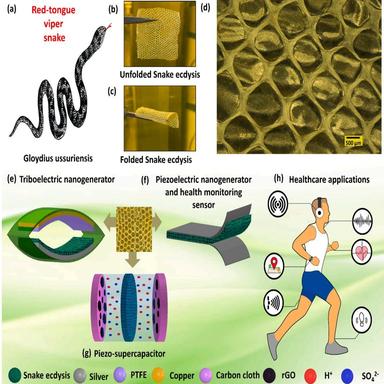
(a) Pictorial image of gloydiusussuriensis snake. The flexibility images of snake ecdysis. (b) Unfolded snake ecdysis. (c) Folded snake ecdysis. (d) Optical images of ecdysis at 50 ×, schematic diagram of the energy harvesting and storage devices such as (e) triboelectric nanogenerator, (f) piezoelectric nanogenerator, and (g) piezo-supercapacitor. (h) Advanced health monitoring and encouraging electronic applications of snake ecdysis-based electronic devices.